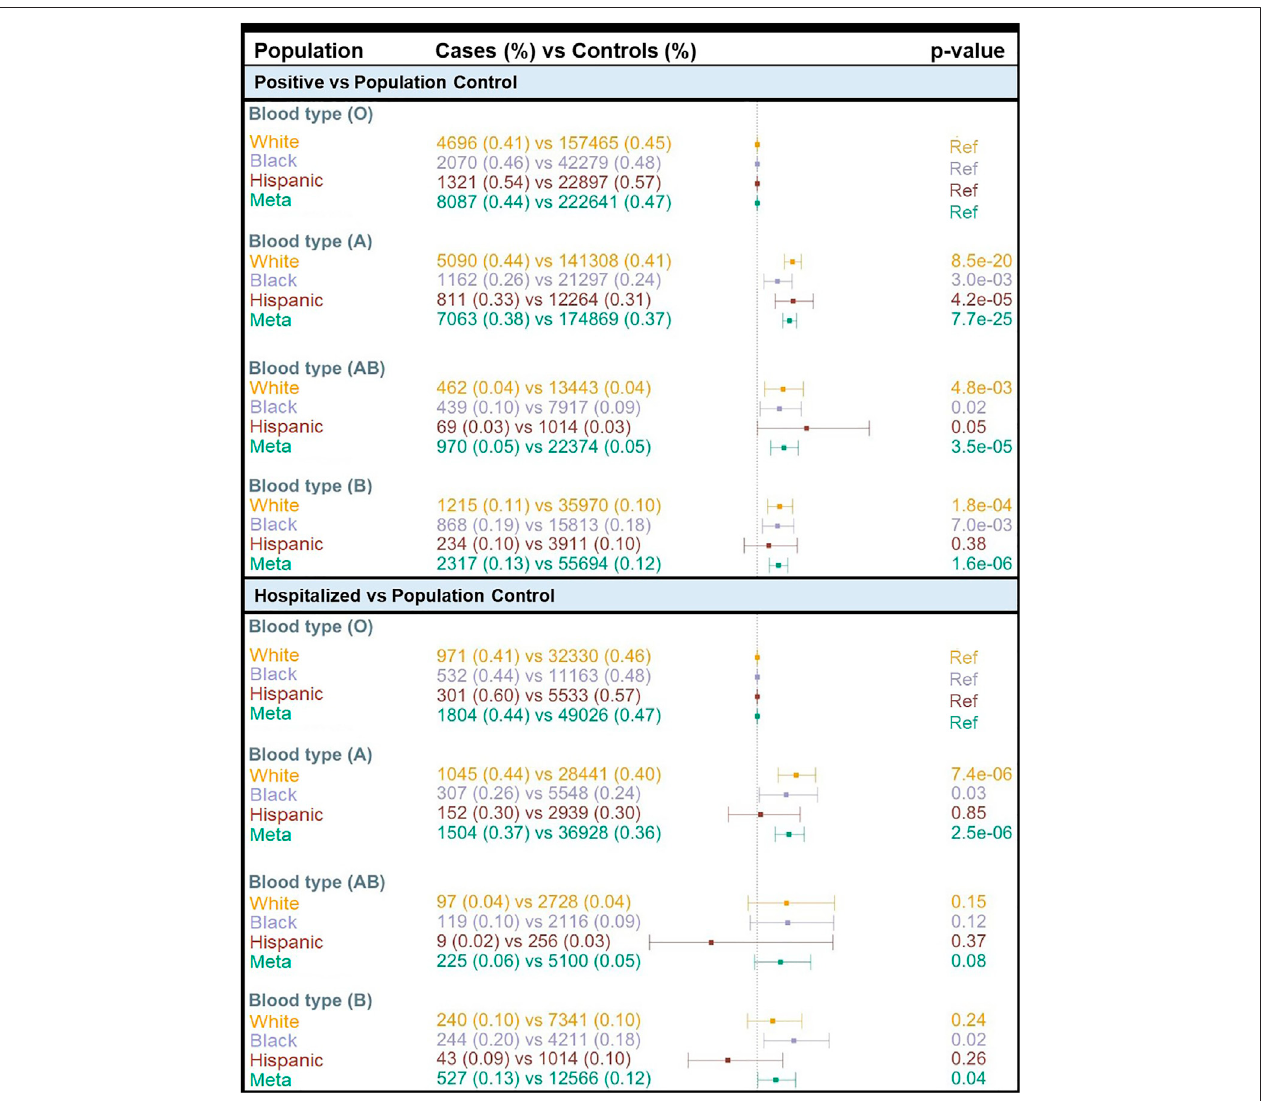
FIGURE 2 | Association of COVID-19 with ABO blood type by population. OR (cid:1) odds ratio; Meta (cid:1) Multi-population meta-analysis; Ref (cid:1) Reference.